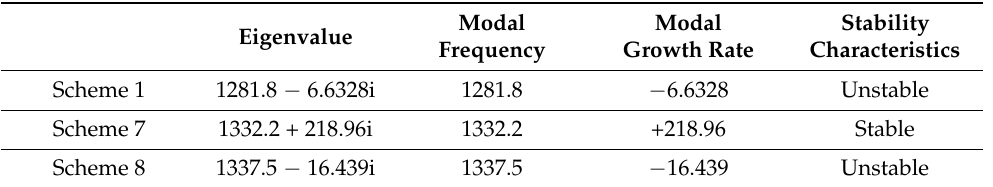
Table 8. Frequency and stability of the first-order longitudinal, zero-order tangential, zero-order radial modes for Schemes 1, 7, and